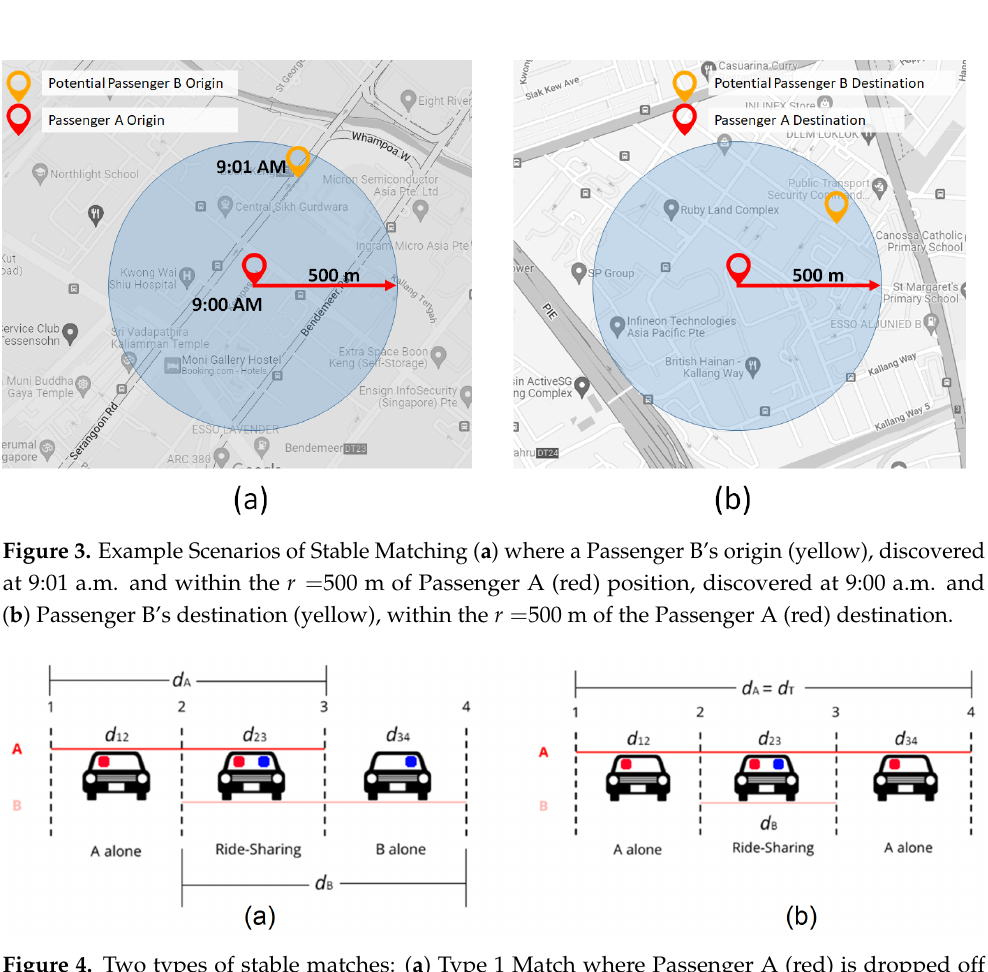
Figure 4. Two types of stable matches: ( a ) Type 1 Match where Passenger A (red) is dropped off first at point 3, then passenger B (blue) at point 4 and ( b ) Type 2 Match where Passenger B (blue) is dropped off first at point 3, then Passenger A (red) at point